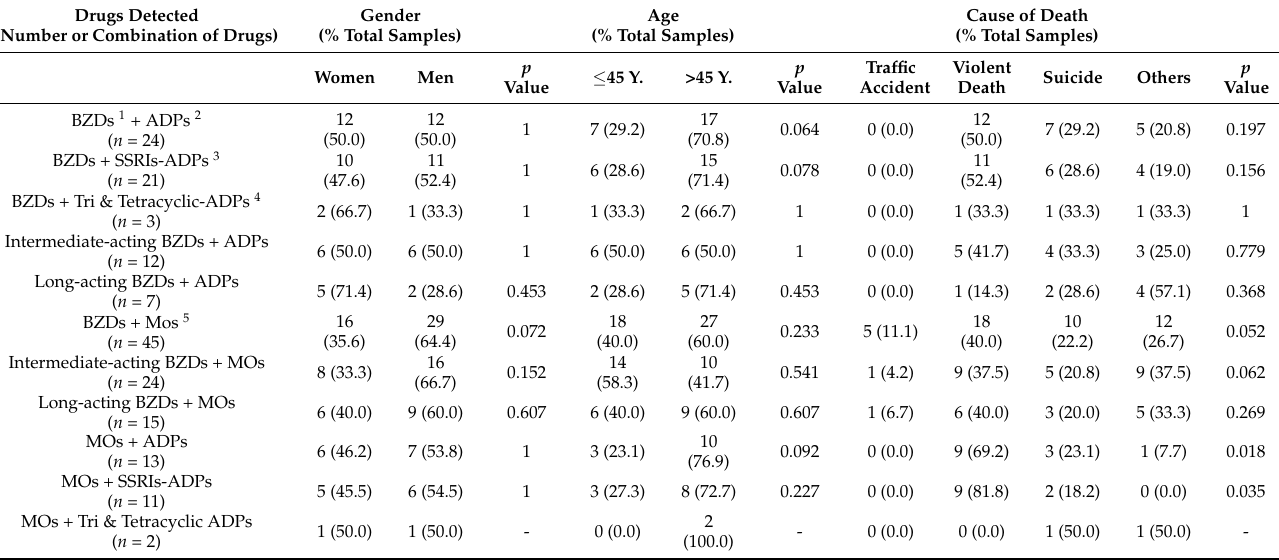
Table 4. Relationship between number/combination of drugs detected and sociodemographic and forensic